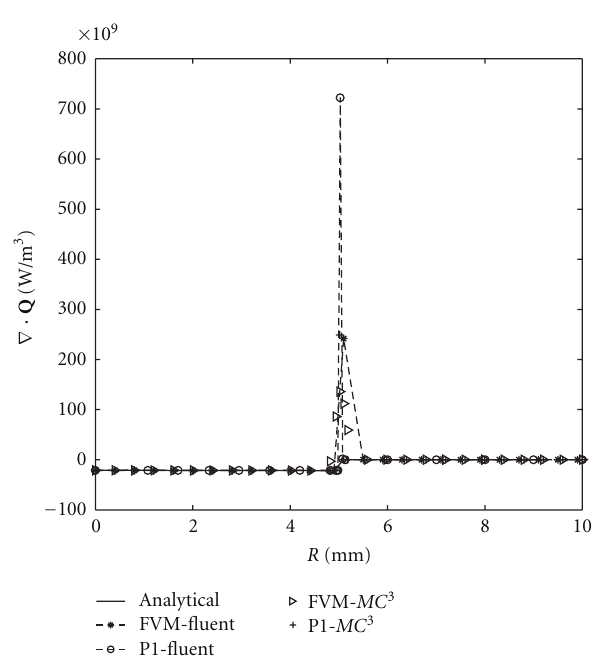
Figure 6: Test case III. Source term for an opaque band.